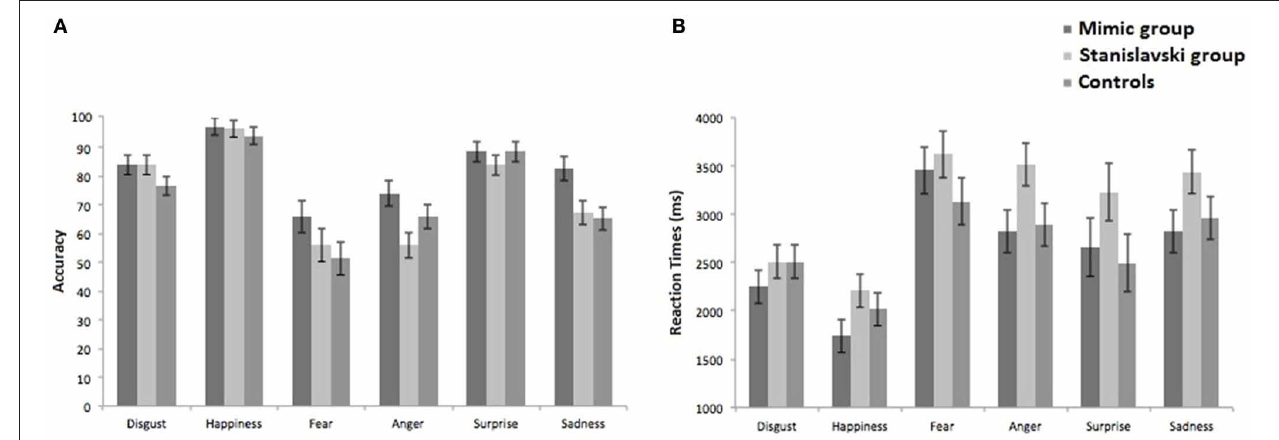
FIGURE 2 | Percentages of correct responses (A) and RTs (B) plotted against the six emotions, separately in the three groups. Bars represents